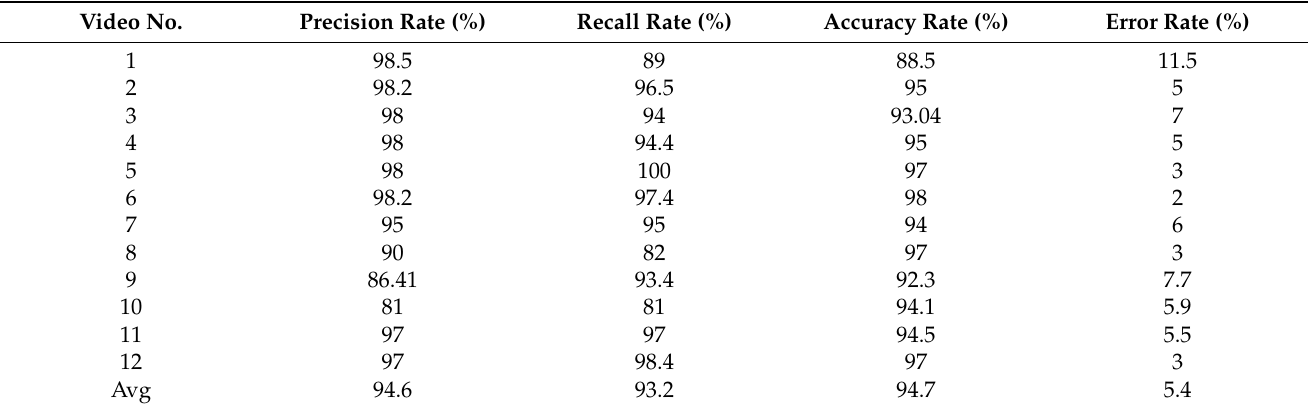
Table 5. Results of Video Summarization for Cricket Video